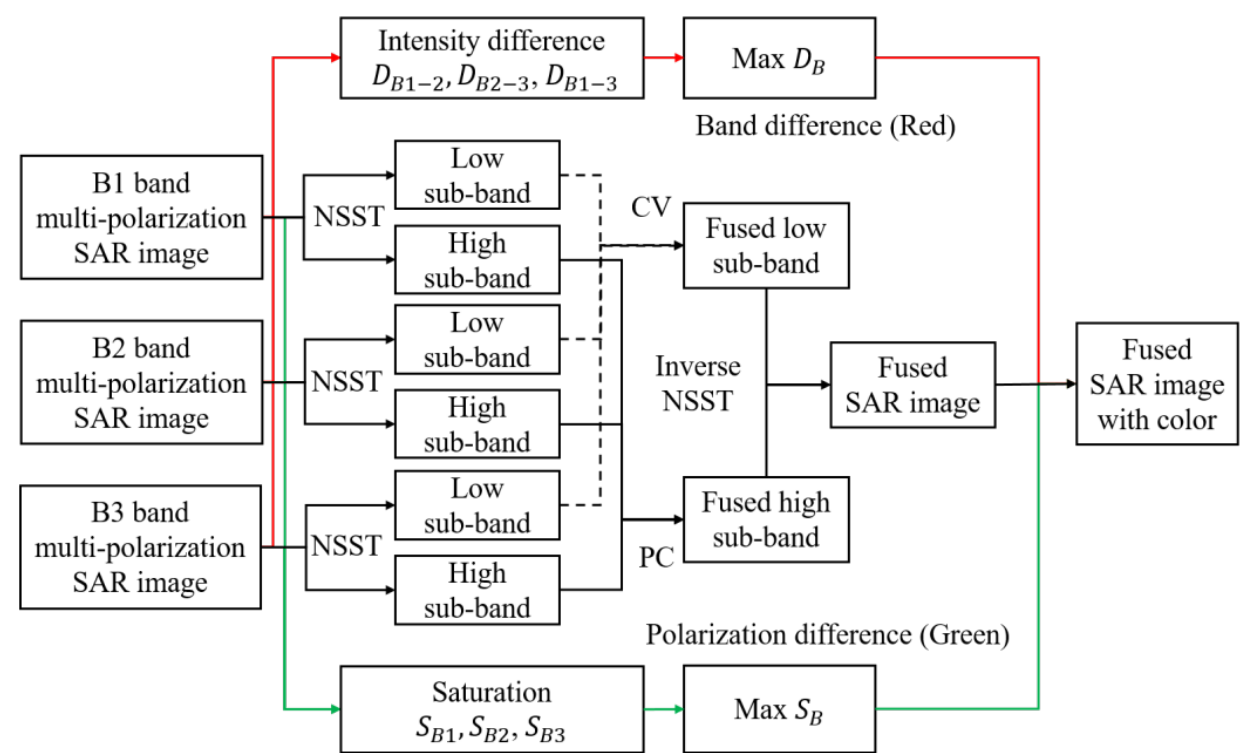
Figure 2. Flow chart of the proposed fusion method for multi-band and polarization SAR images.